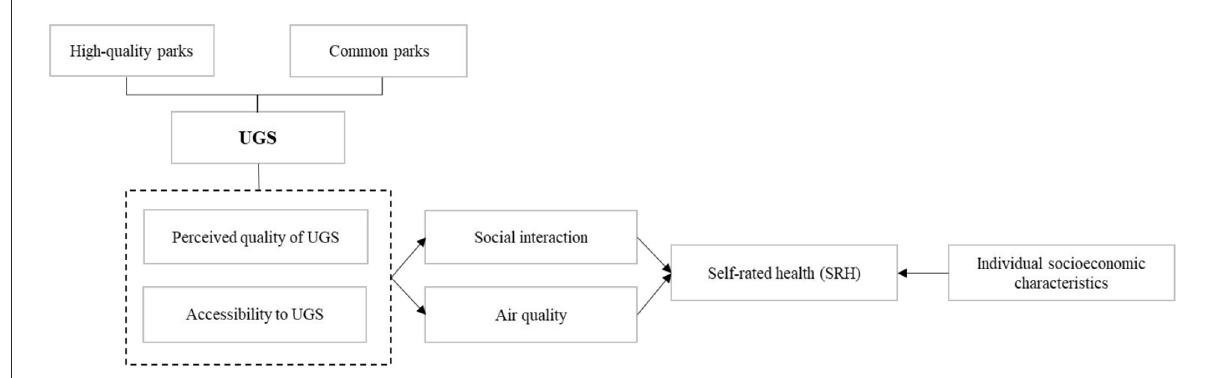
FIGURE1 Research framework for the association between UGS and residents’